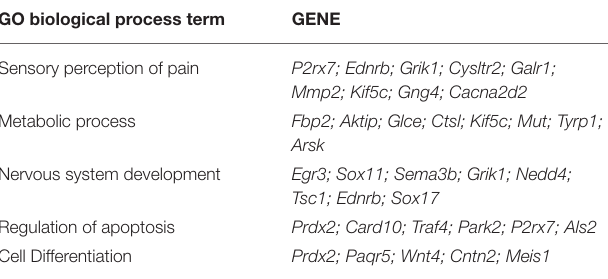
TABLE 1 | Enriched biological processes for differentially expressed genes in Meis1cko